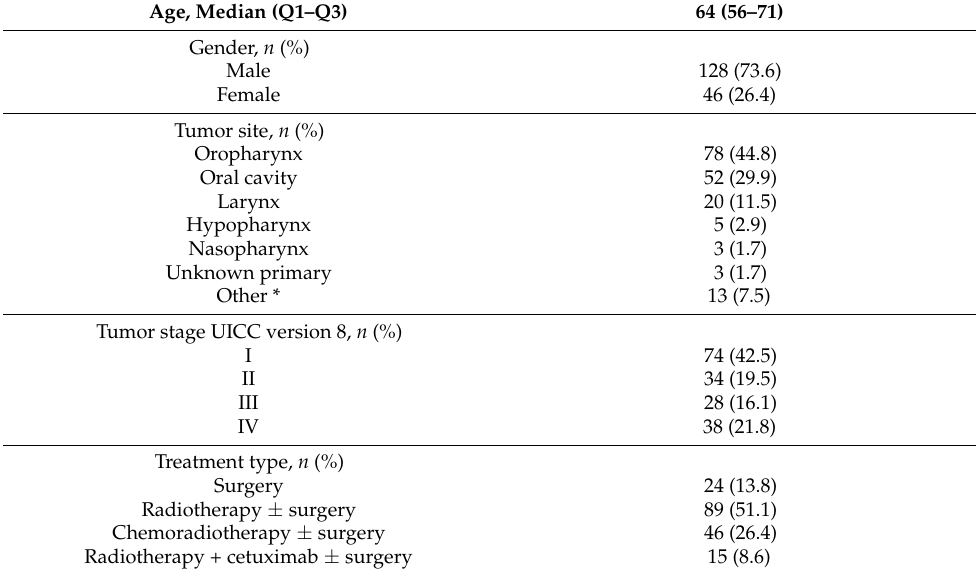
Table 1. Characteristics of patients with head and neck cancer ( n =